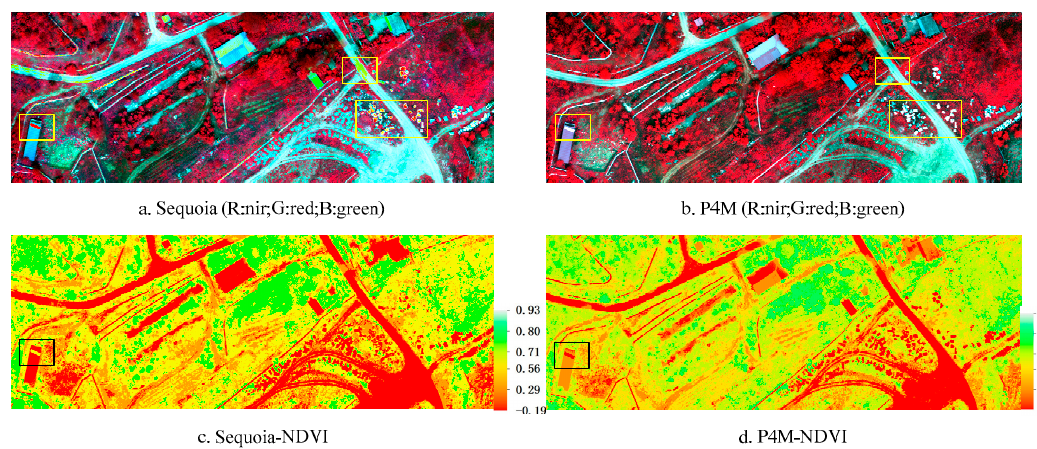
Figure 5. Image pairs of Sequoia and P4M (5 cm) after data processing: ( a , b ) two false color composites formed by the combination of near-infrared, red, and green bands; ( c , d ) normalized difference vegetation index (NDVI) products of the two sensors. The left side corresponds to the Sequoia camera, and the right side corresponds to the P4M camera. The yellow squares indicate the difference between Sequoia-derived RGB and P4M-derived RGB; the black squares indicate the difference between Sequoia-NDVI and P4M-NDVI.